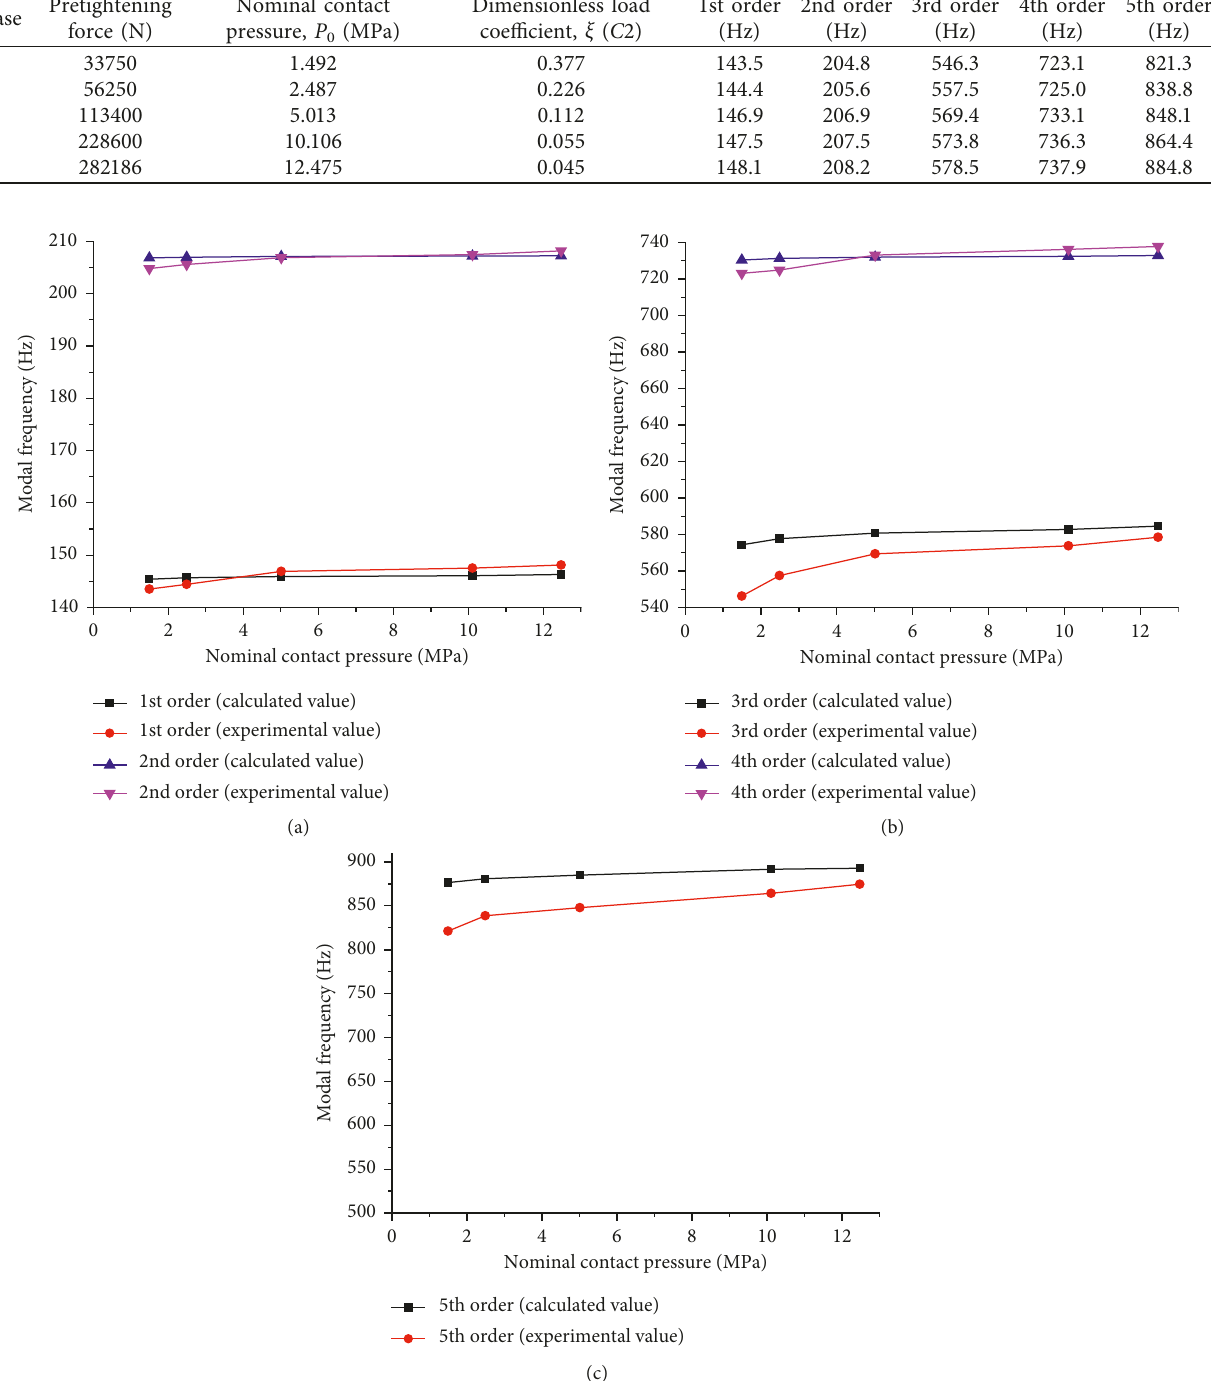
Figure 15: The comparison of modal frequency between the calculated and experimental results. (a) 1st and 2nd order modal frequency. (b) 3rd and 4th order modal frequency. (c) 5th order modal frequency.